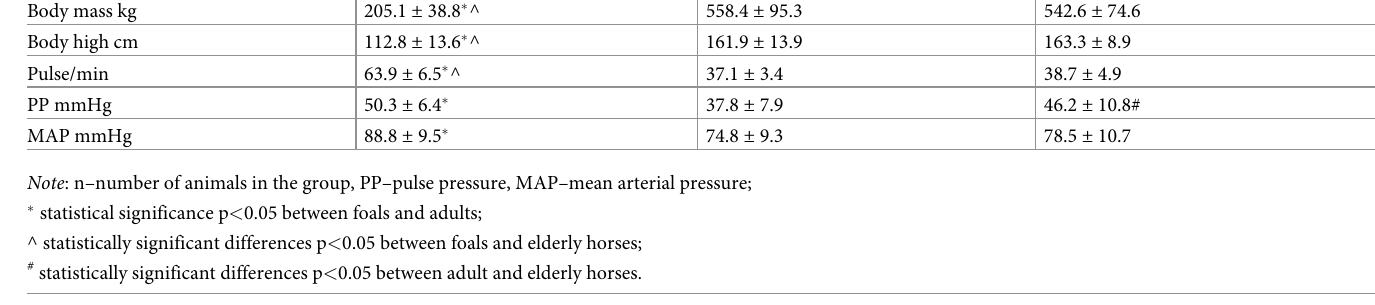
Table 1. Mean values with standard deviation of body mass, height, pulse frequency, pulse pressure and mean arterial pressure in examined foals, adults and elderly horses.